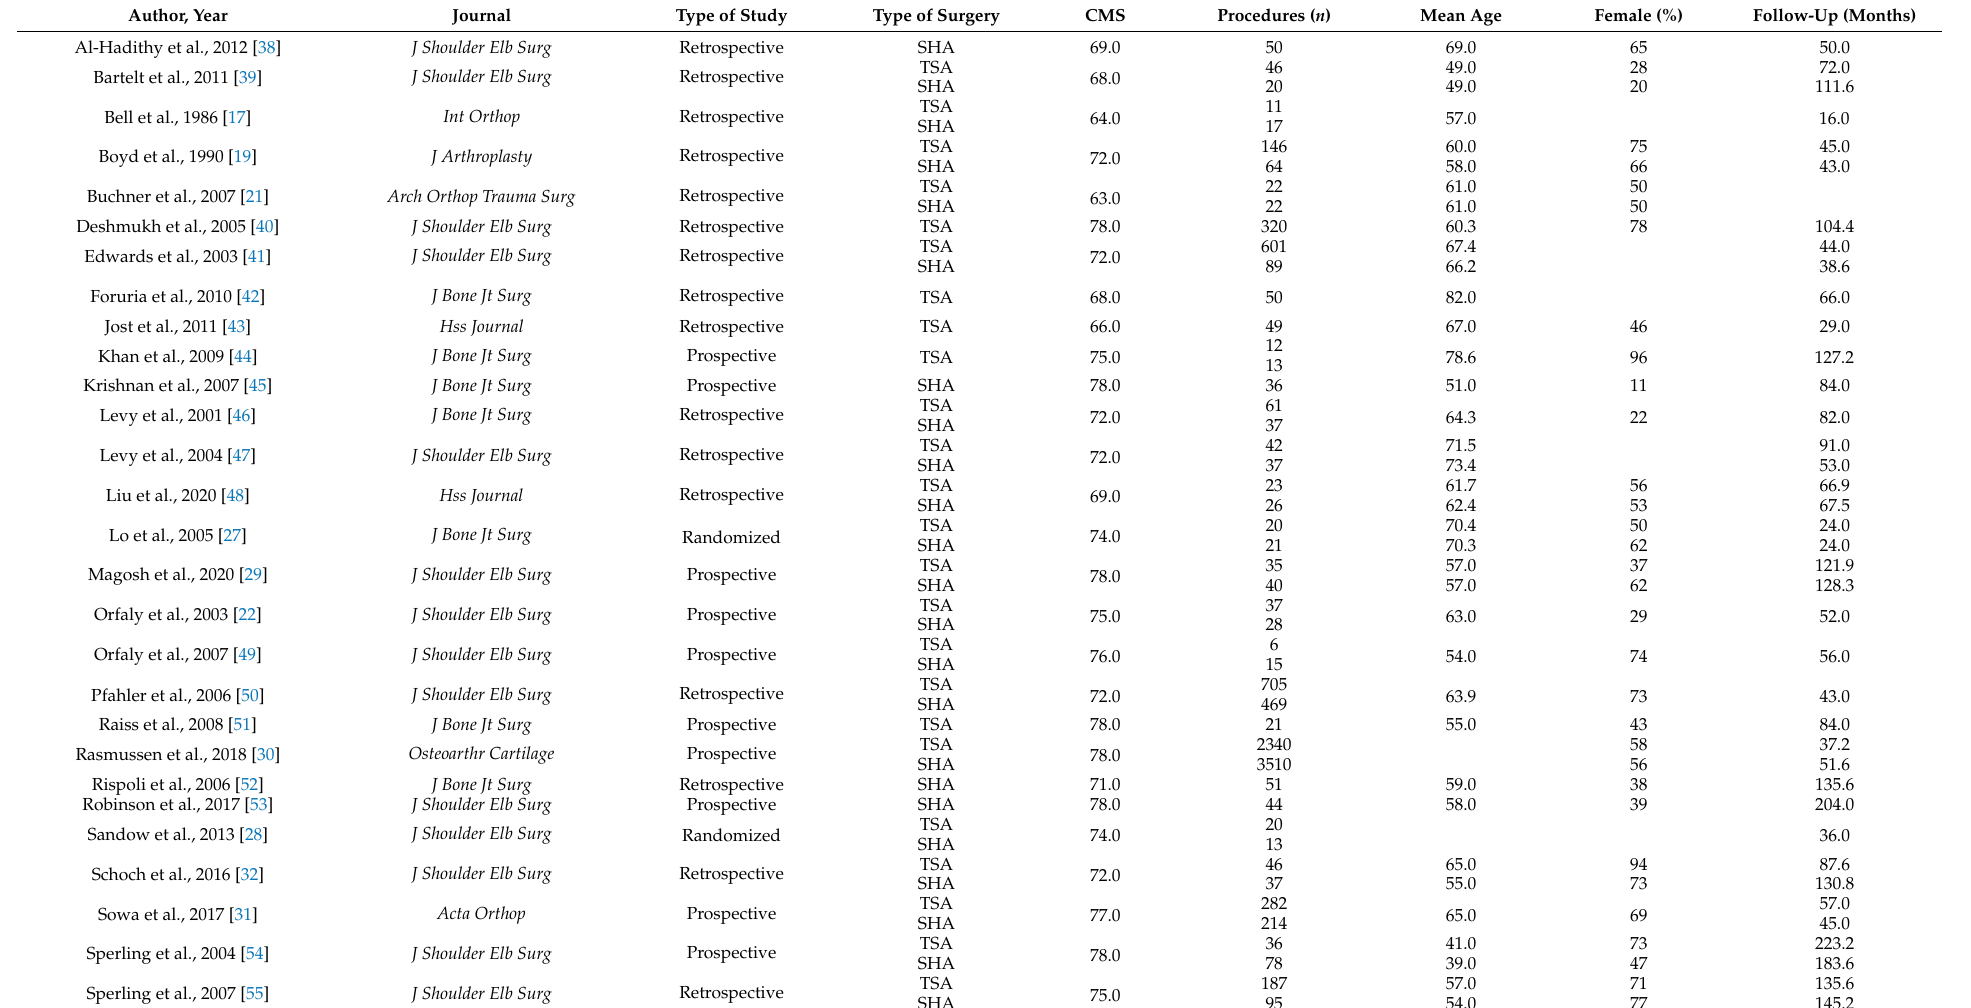
Table 3. Generalities and patient baseline of the included